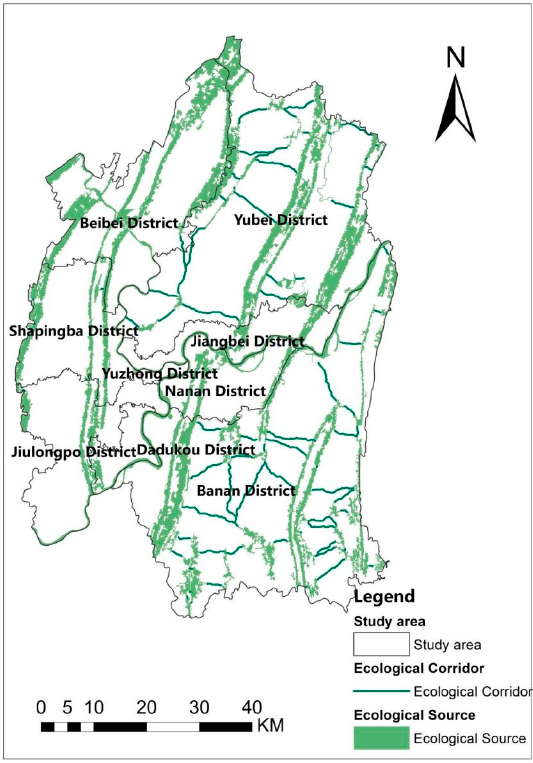
Figure 7. Ecological corridor distribution.